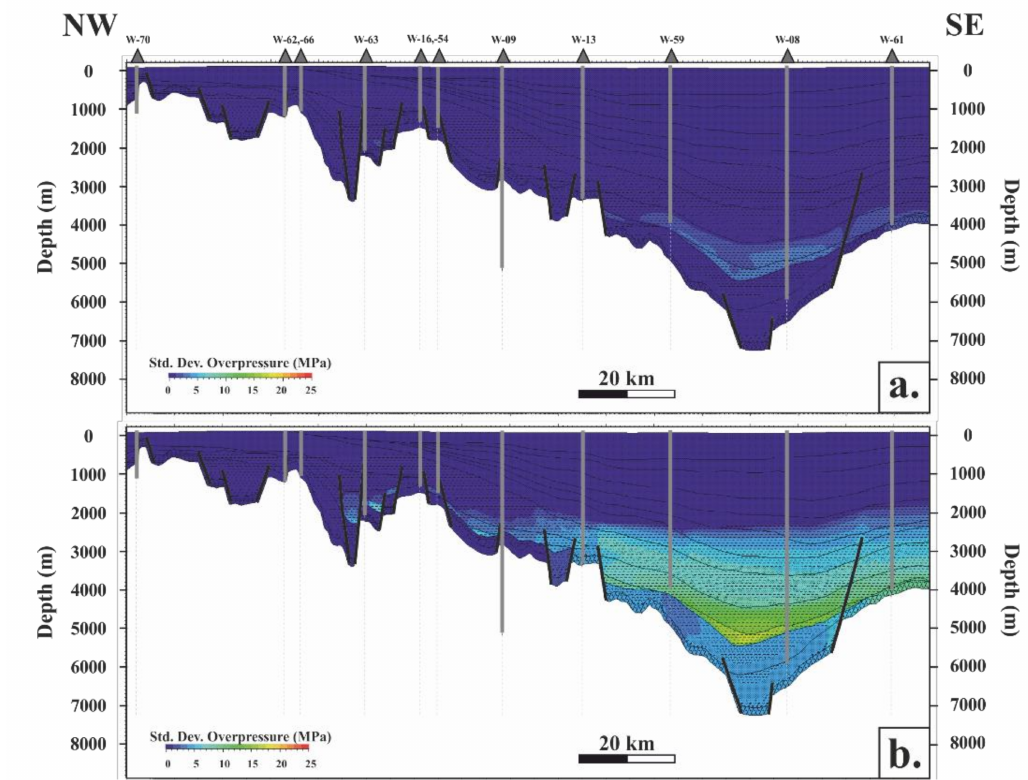
Figure 12. The uncertainty of the input parameters results in different magnitudes of subsurface pressure uncertainties along Section_01: ( a ) the depth uncertainty could generate only a slight deviation; ( b ) the permeability has one magnitude higher importance in the subsurface pressure